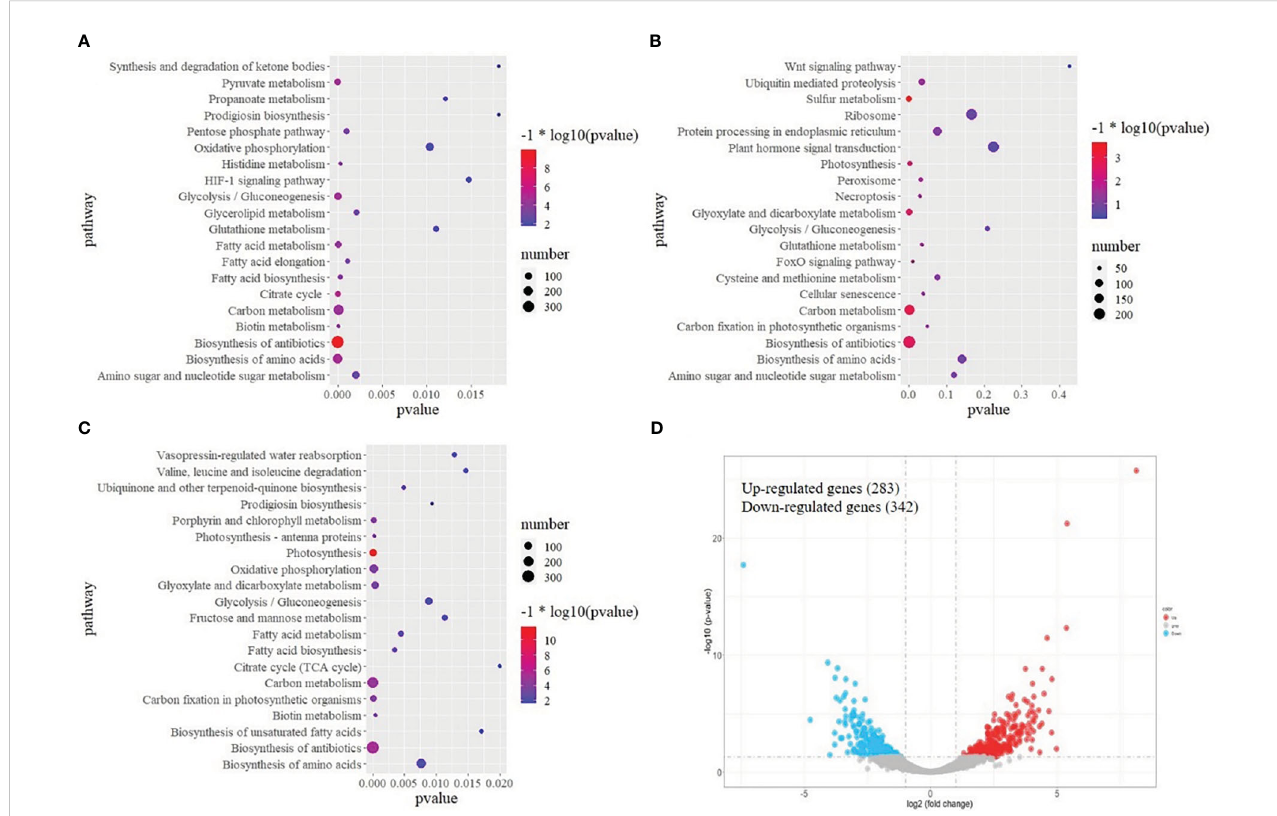
FIGURE 2 KEGG pathway enrichment of DEGs. (A) Pathway enrichment based on DEGs between normal and cold-treated Arbequina. (B) Pathway enrichment based on DEGs between normal and cold-treated Koroneiki. (C) Pathway enrichment based on DEGs between cold-treated Arbequina and Koroneiki. (D) Volcano plots of DEGs between cold-treated Arbequina and